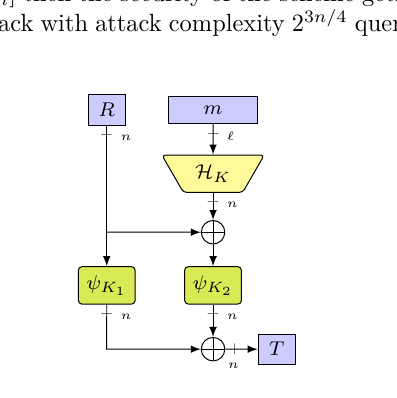
Figure 1.1: Figure of EHtM ; ψ K n -bit (cid:15) -AXU hash function. R is a n bit salt and m is message of at most ‘